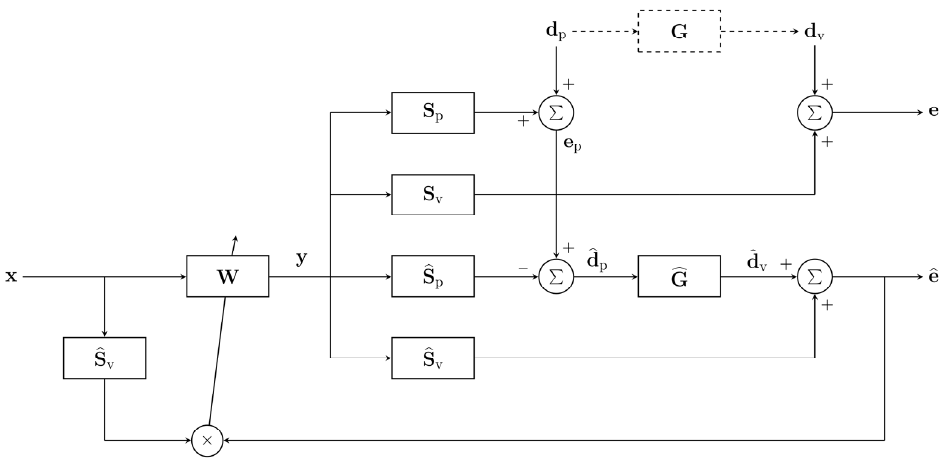
Figure 2. Block diagram of the FxLMS algorithm with the remote microphone technique.